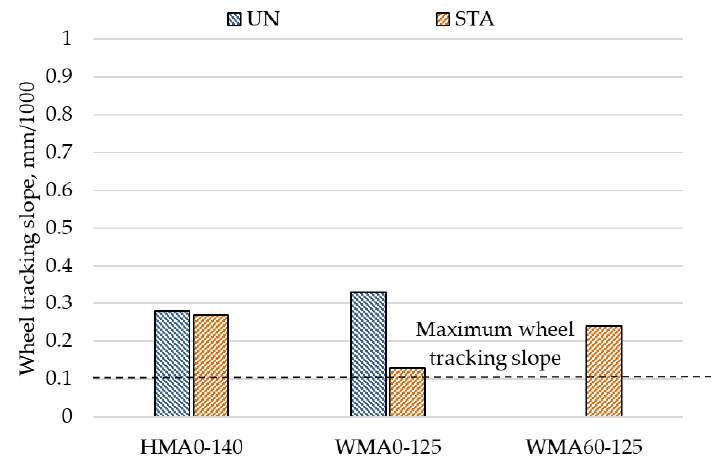
Figure 6. Wheel tracking slope results.